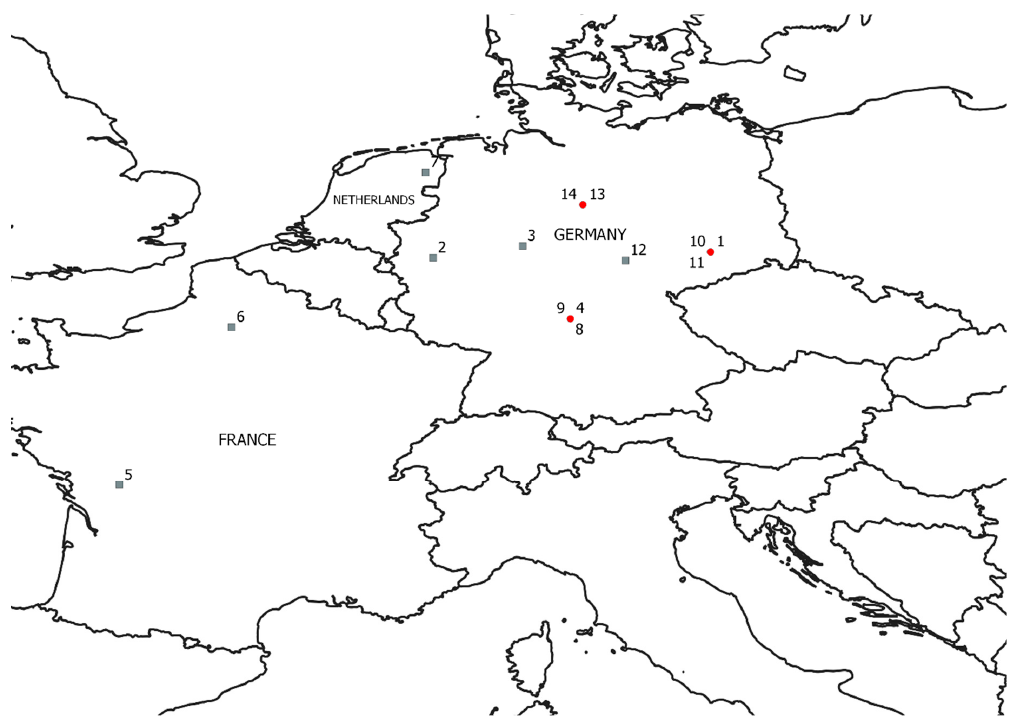
Figure A1. Map of locations of study fields. Numbers correspond to field numbers in Table A1.